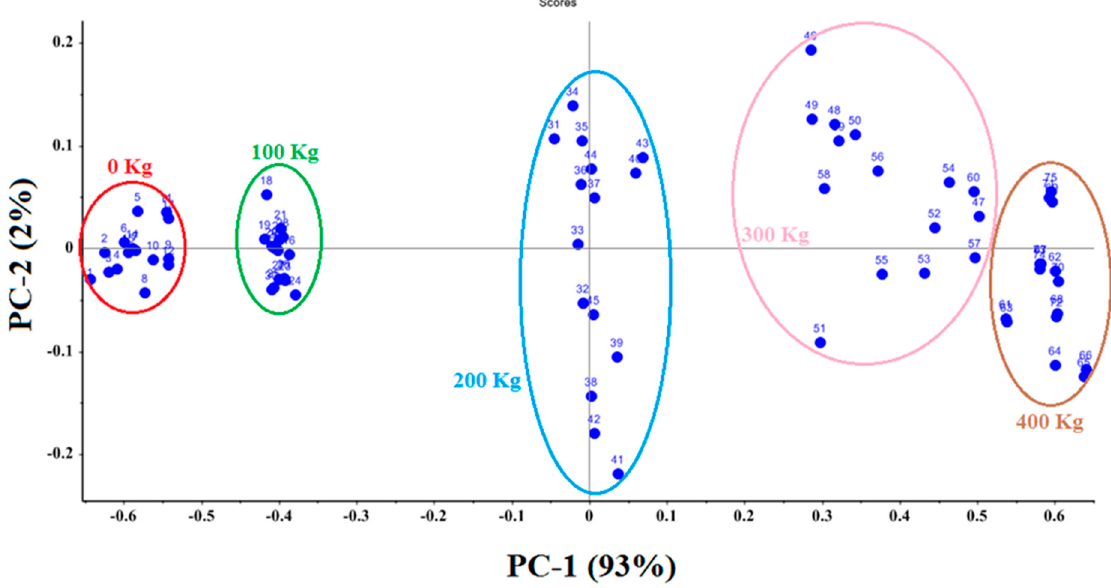
Figure 4. Score plot PCA analysis for different levels of applied urea fertilizer.